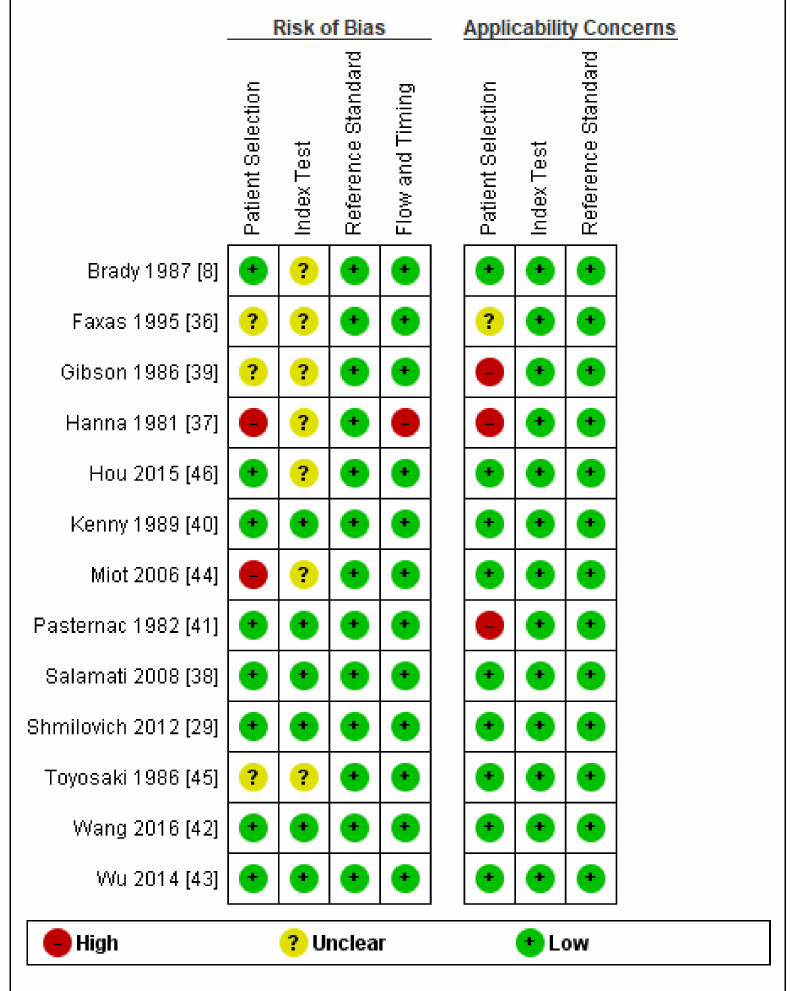
Figure 3. Results of quality assessment of individual